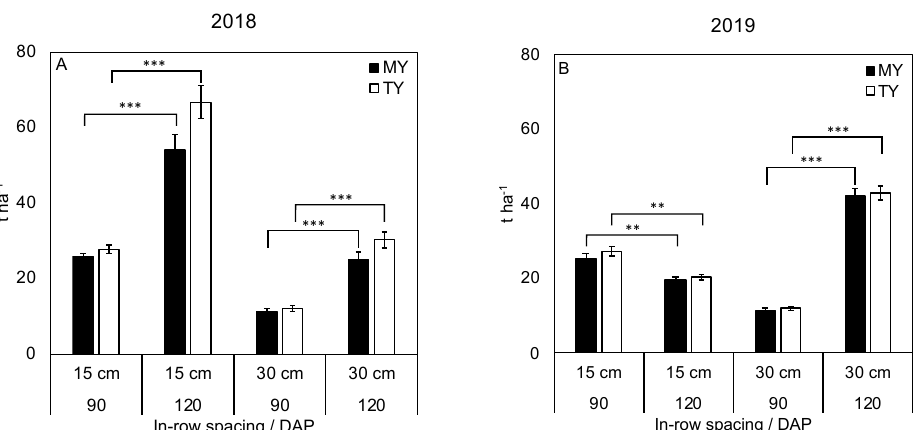
spacing, 120 DAP; 2019 = 30 cm in-row spacing, 120 DAP (Table 3)). Both MS (30 cm in-row spacing, 90 DAP) and 413 (30 cm in-row spacing, 120 DAP) produced the lowest MY in 2018, with 4.4 and 4.5 t ha − 1 , respectively. However, in 2019 the lowest MY was produced by ‘Japanese’ (6.8 t ha − 1 ) and ‘Covington’ (9.2 t ha − 1 ), both varieties under 30 cm in-row spacing and harvested at 90 DAP.